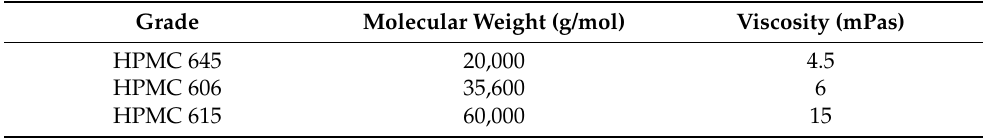
Table 1. Specifications of hydroxypropyl methylcellulose (HPMC)